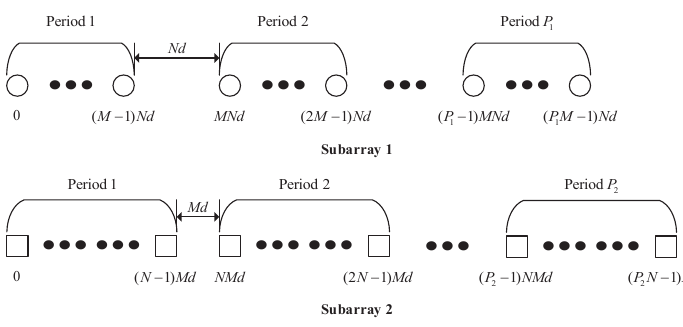
Figure 1. The coprime array with multiperiod